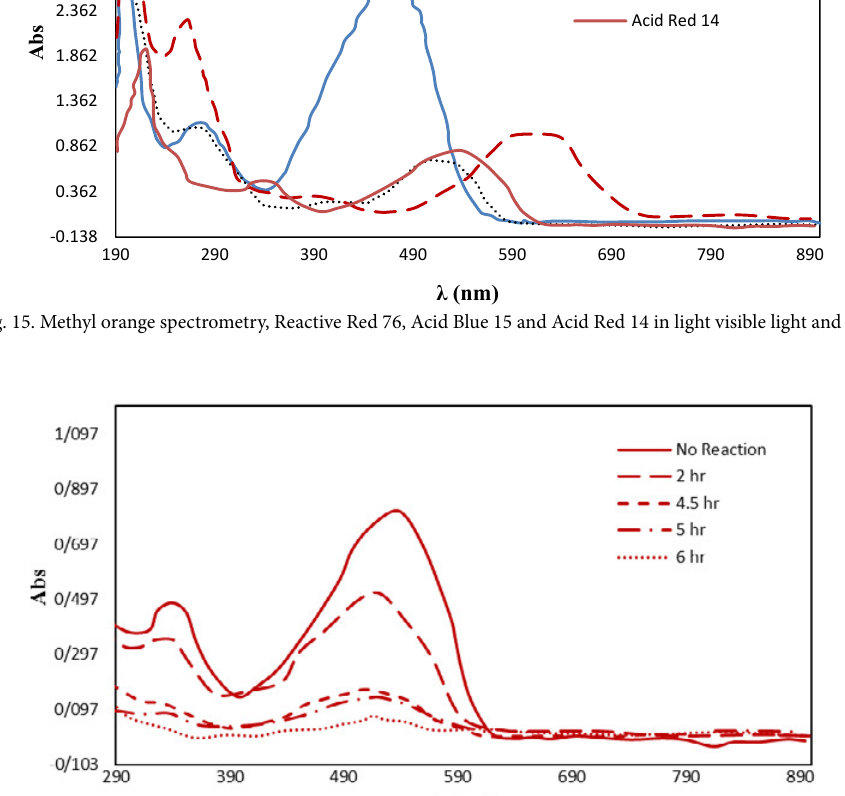
Fig. 16. UV-Vis spectra changes of red 14 during the photocatalytic reaction Nanocomposite dosage = 0.5 g/L, dye concentration = 50 ppm, DO = 7/4 mg/L, pH= 7)